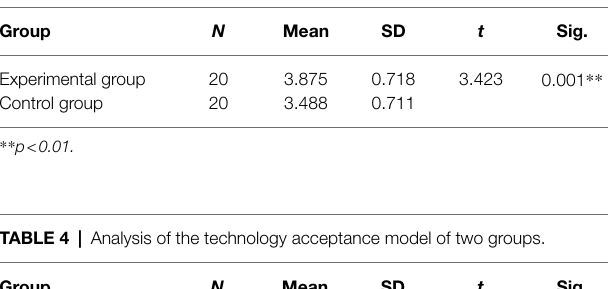
TABLE 4 | Analysis of the technology acceptance model of two groups. Group N Mean SD t Sig. Experimental group 20